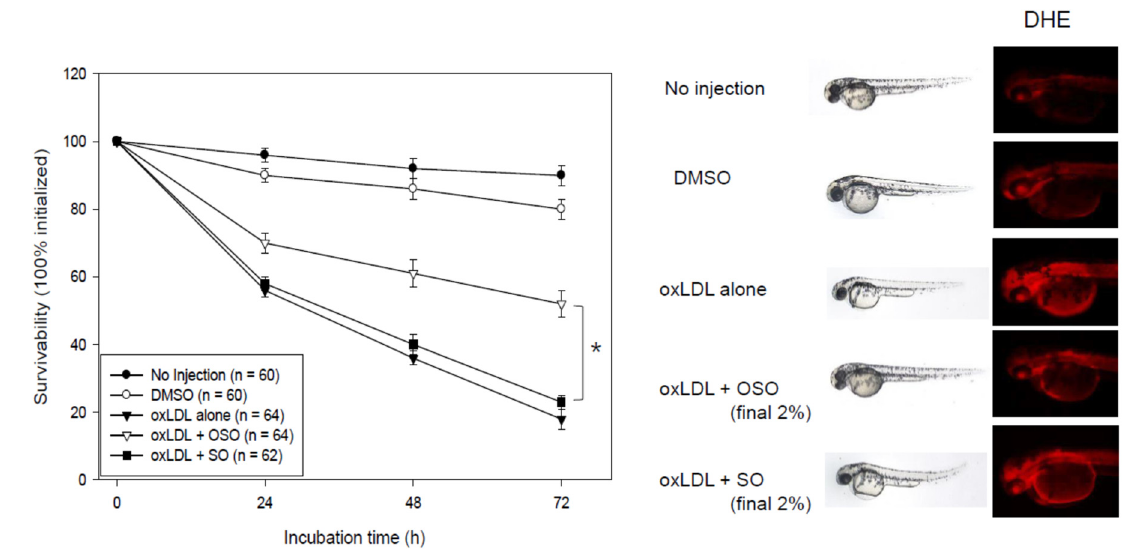
Figure 9. Survival of zebrafish embryos after a co-injection of oxLDL (15 ng of protein) plus ozonated sunflower oil (OSO) or sunflower oil (SO). Fluorescence image (Ex = 588 nm, Em = 605 nm) of a zebrafish embryo was obtained from dihy- droethidium (DHE) staining, as described in the text. * p < 0.05 between OSO- and SO- injected embryo.